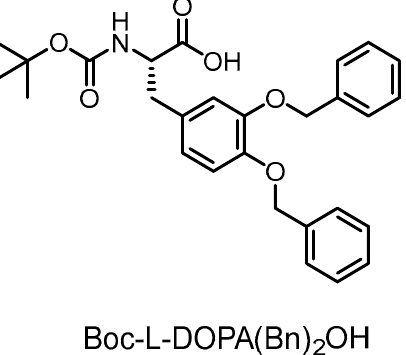
Figure 1. Chemical structure of the gelator.